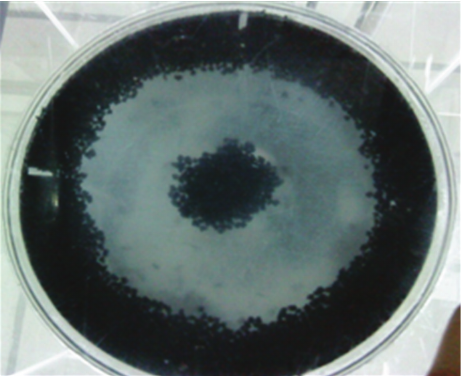
Figure 9: Particle distribution by 6MFD.